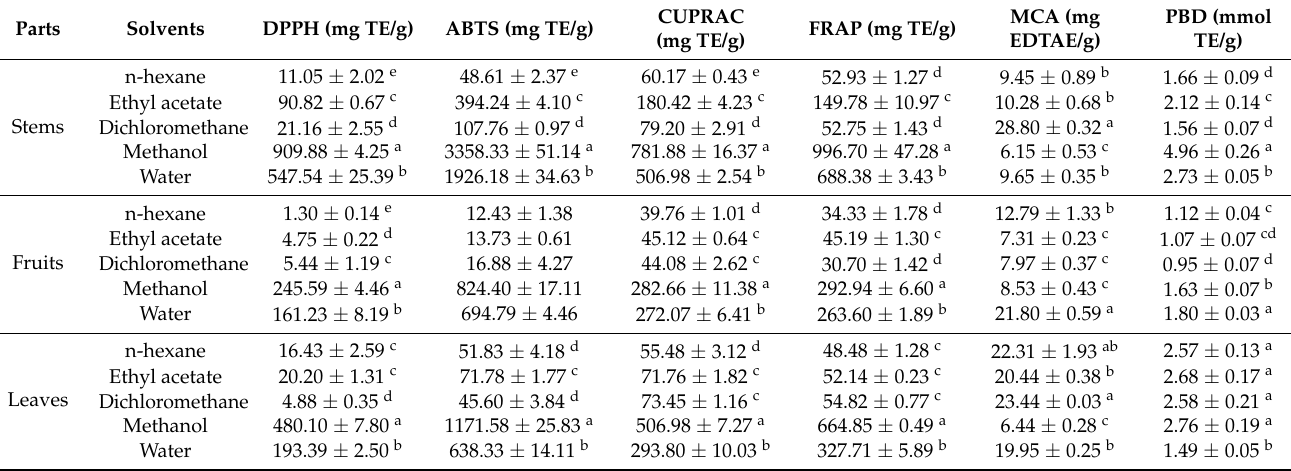
Table 2. Antioxidant properties of the tested